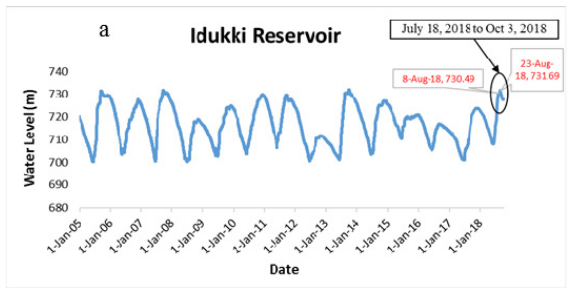
simulated flows was observed as compared with CWC